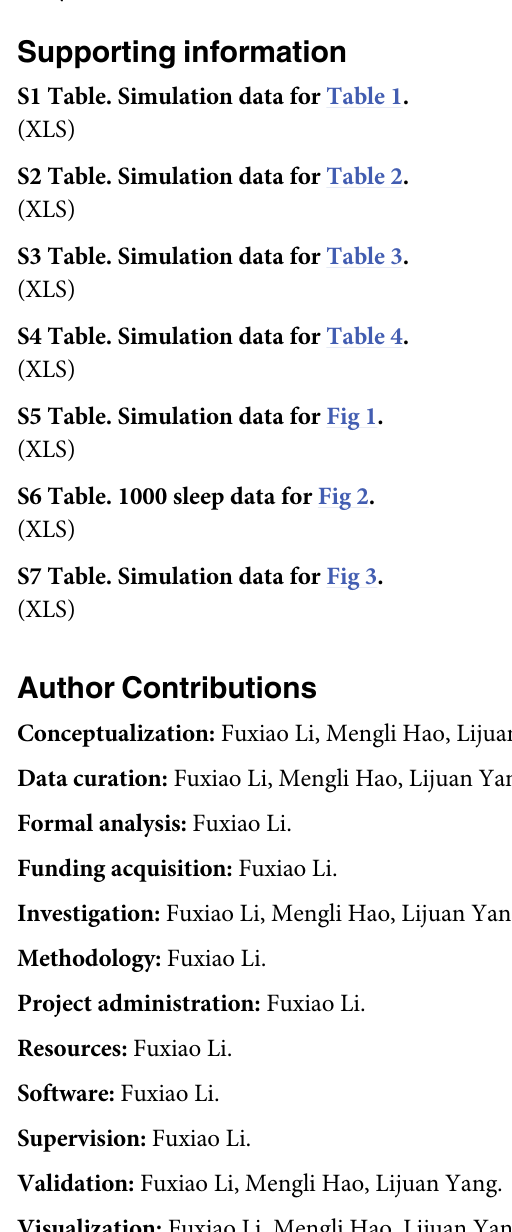
S1 Table. Simulation data for Table 1. S2 Table. Simulation data for Table 2. S3 Table. Simulation data for Table 3. S4 Table. Simulation data for Table 4. S5 Table. Simulation data for Fig 1. S6 Table. 1000 sleep data for Fig 2. S7 Table. Simulation data for Fig